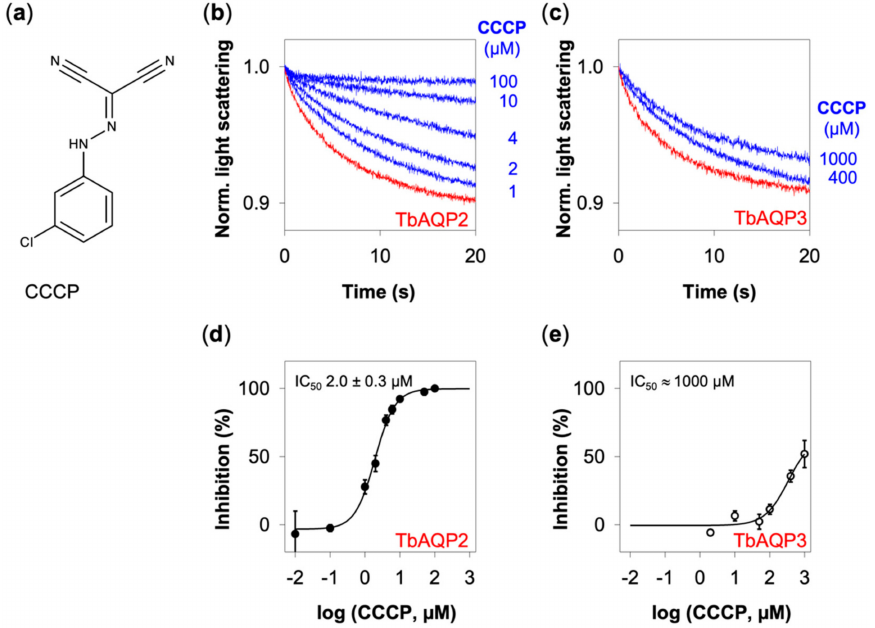
Figure 3. Inhibition of TbAQP2 and TbAQP3 by CCCP. ( a ) Chemical structure of CCCP. ( b ) Shown are normalized light scattering signals from TbAQP2 glycerol permeability in the absence (red trace) and presence of CCCP (blue traces). For clarity only selected CCCP concentrations are shown. ( c ) Shown are normalized light scattering signals from TbAQP3 without (red trace) and with CCCP (blue traces). For clarity concentrations below 400 µ M of CCCP are not shown. The curves in ( b , c ) were obtained from 7–9 averaged traces and normalization. ( d ) IC 50 curve of TbAQP2 inhibition by CCCP. ( e ) Dose-response of TbAQP3 after incubation with CCCP. Error bars indicate SEM ( n = 2–5). In all experiments, the DMSO concentration was kept ≤